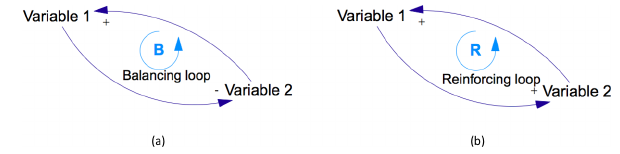
Figure 4. CLD: variables, causal links, and feedback loops.